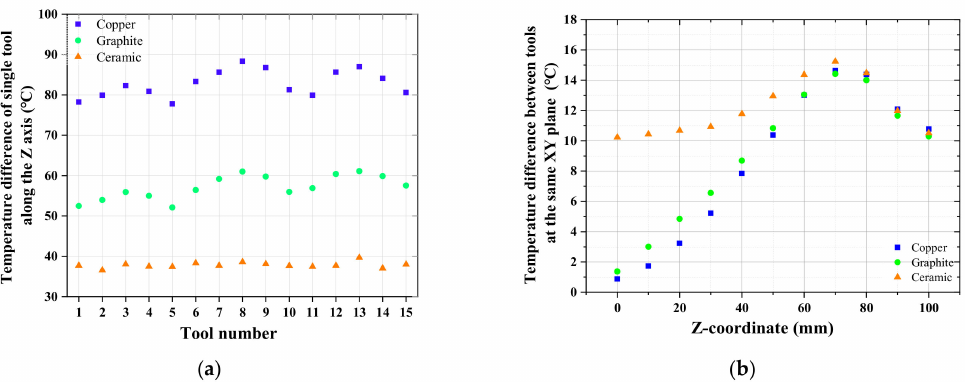
Figure 4. ( a ) The temperature di ff erence of No. 1–15 tool along the Z axis; ( b ) The temperature di ff erence between the 15 tools at the same XY plane along the Z axis for the various supporting